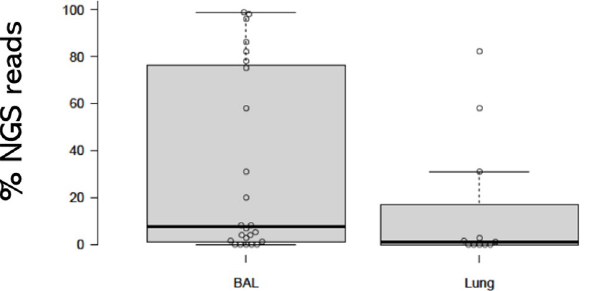
Fig 5. The percentage of NGS reads attributable to F . felis in BALF specimens. The percentage of NGS reads attributable to F . felis in BALF specimens from 24 cats with lower airway disease comapred to in 16 lung necropsy specimens. It was not uncommon for F . felis to be the preponderant organism in cats with lower respiratory disease, but this was rarely the case in lung specimens from the control necropsy cat, except for the cat that died of intersitial